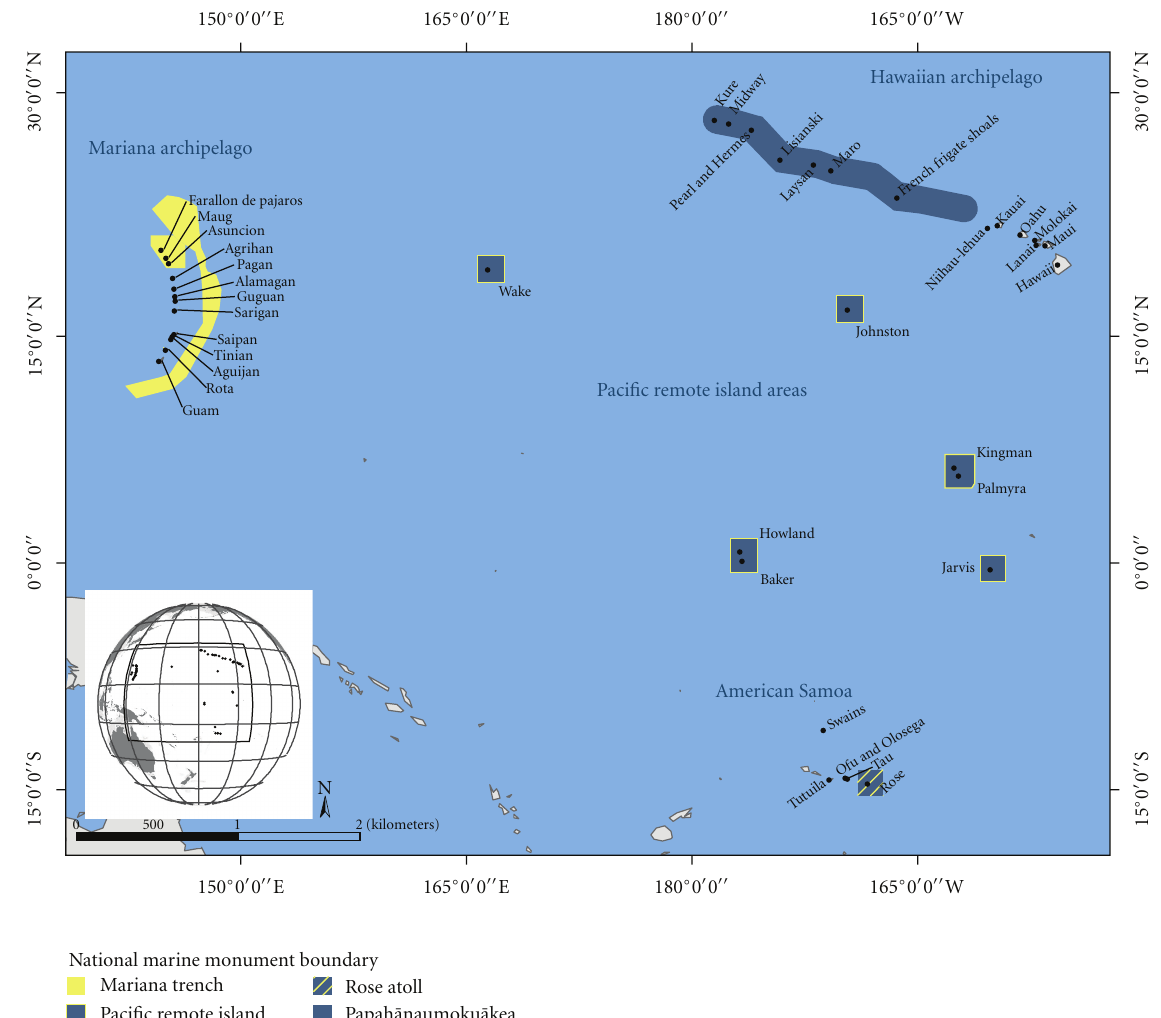
Figure 1: Locations of the reef-areas (i.e., islands and atolls) surveyed by NOAA CRED for Pacific RAMP between 2008 and April 2010. Boundaries of US Pacific Marine National Monuments are indicated. Note that labels are only shown for reef-areas that were surveyed by the Pacific RAMP in that period. The number of sites surveyed per reef-area is given in Table 1.